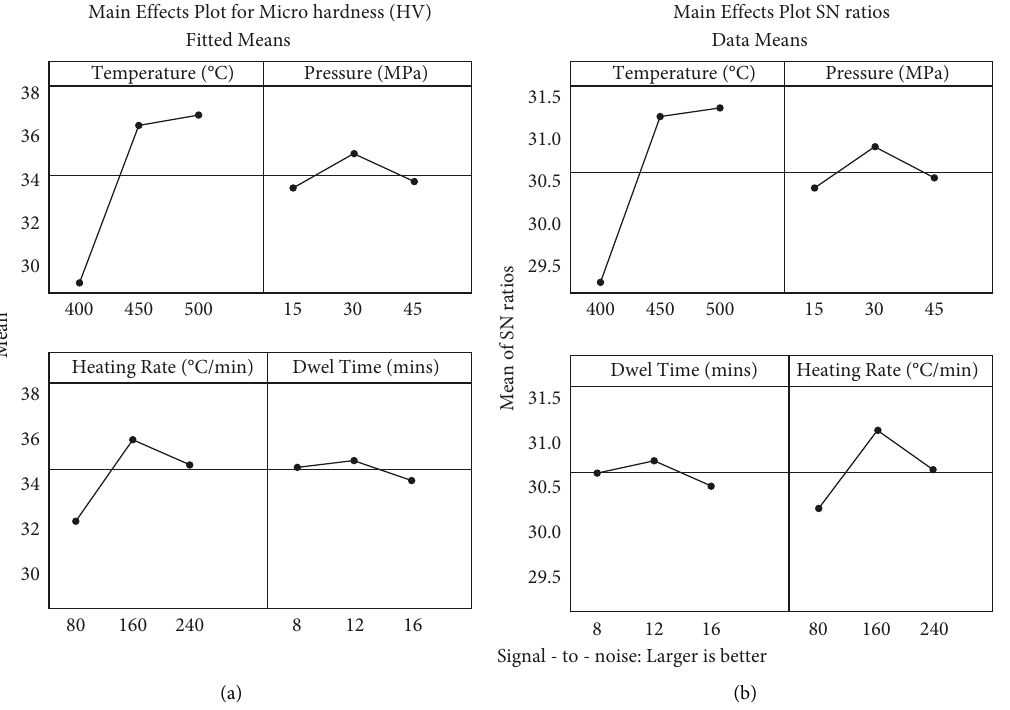
Figure 2: Microhardness main effect plot. (a) Means. (b) Signal to noise